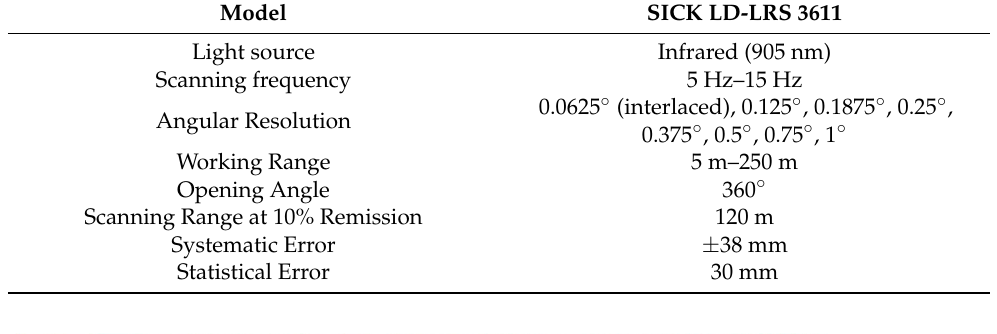
Table 1. LiDAR specifications SICK LD-LRS 3611.